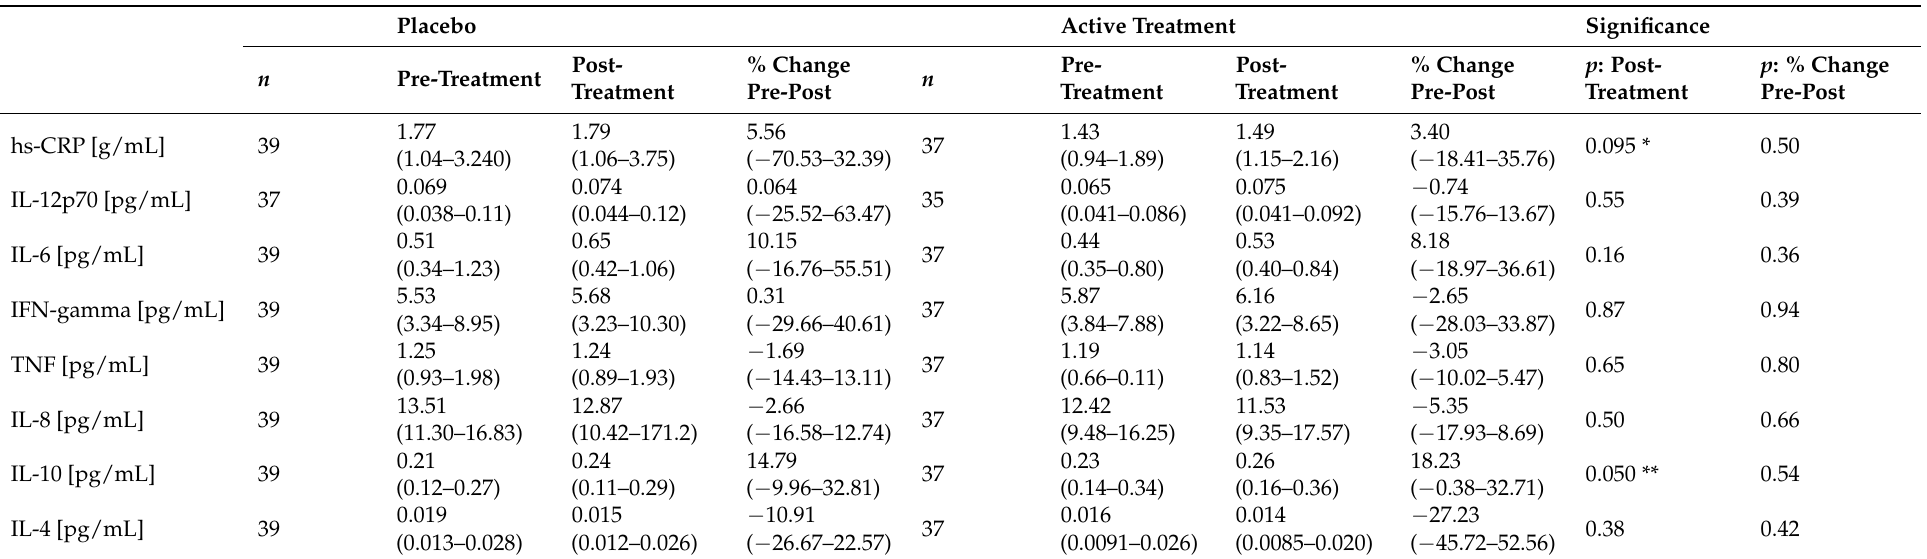
Table 2. Immune-related